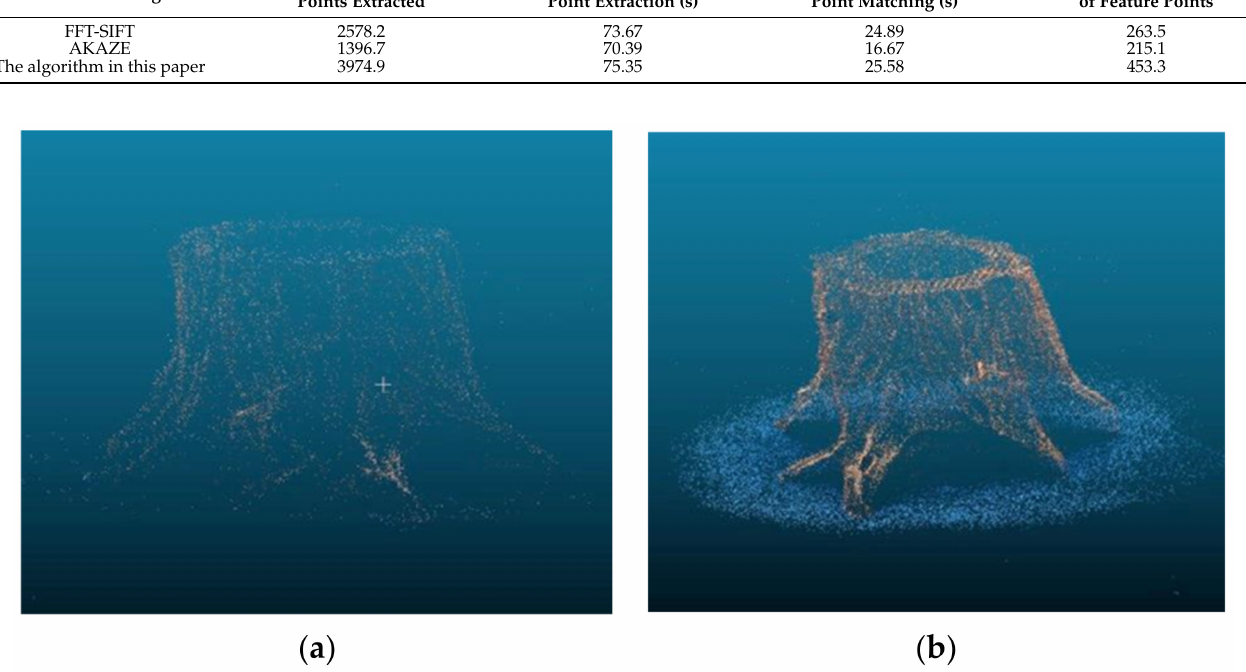
Figure 10. The 3D reconstruction point cloud of traditional SIFT matching algorithm and the 3D reconstruction point cloud of FFT-SIFT-AKAZE. ( a ) The 3D reconstruction point cloud of traditional SIFT matching algorithm; and ( b ) the 3D reconstruction point cloud of